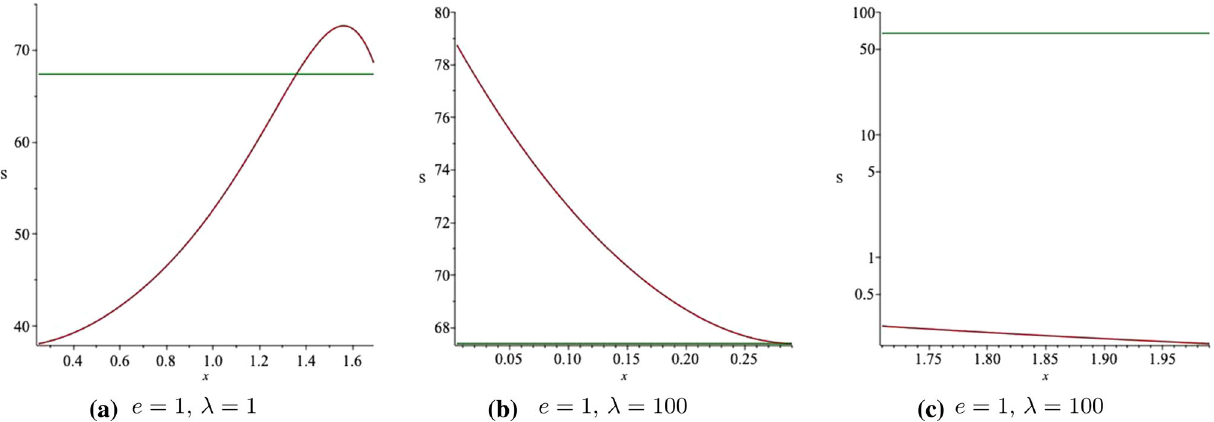
, and S − , respectively II II